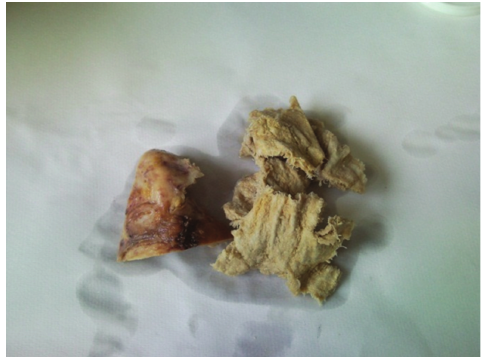
Figure 3: Pathologic findings. Gauze and liver